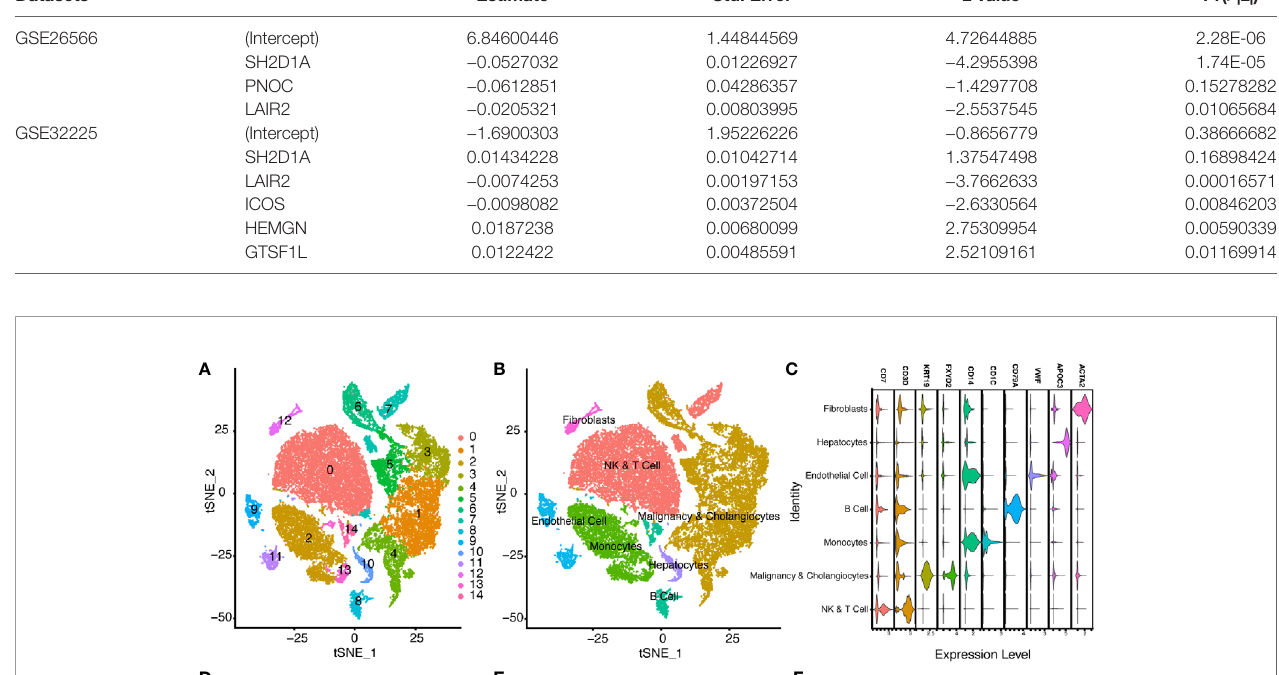
TABLE 1 | Stepwise Regression Model for Compression of Immune In fi ltration Related Genes. Datasets